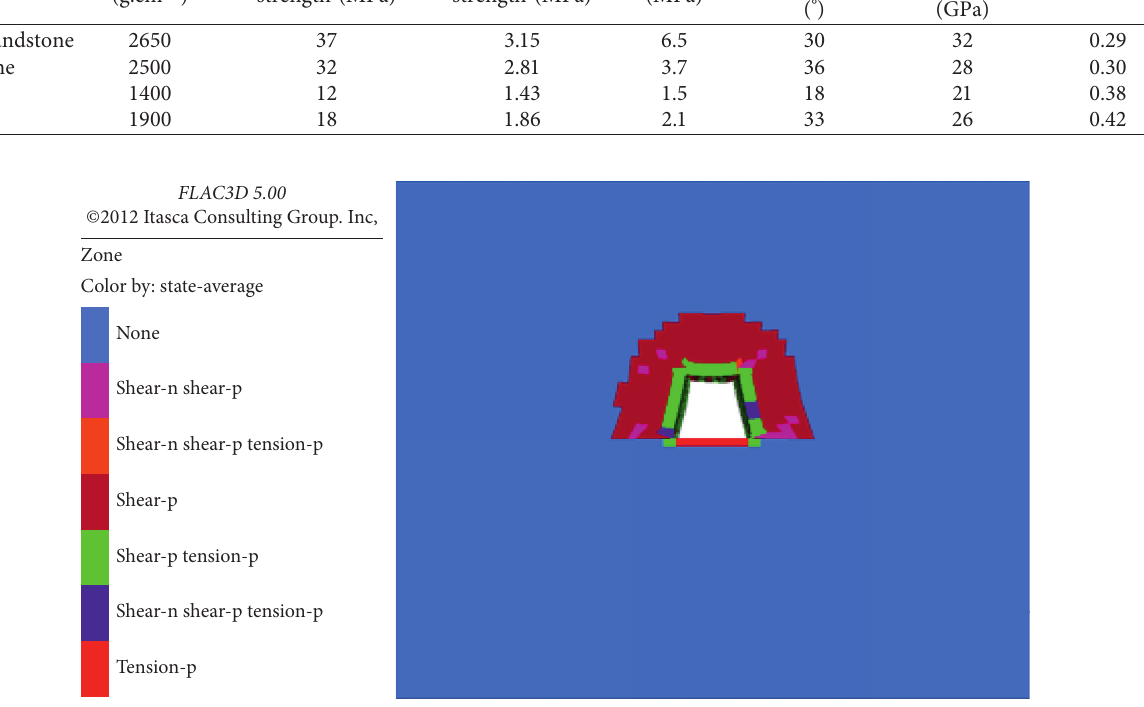
Figure 12: Distribution of the plastic zone in the surrounding rock of the original support technology.